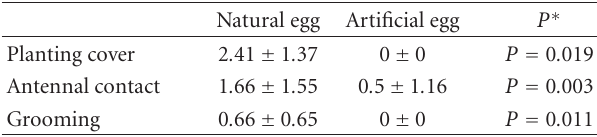
Table 1: Behavioral responses (behavior/10 min ± ; means ± SD) by Apterostigma cf. goniodes workers to natural and artificial eggs. P ∗ refers to the P value from Wilcoxon signed-rank tests; n = 12 observation